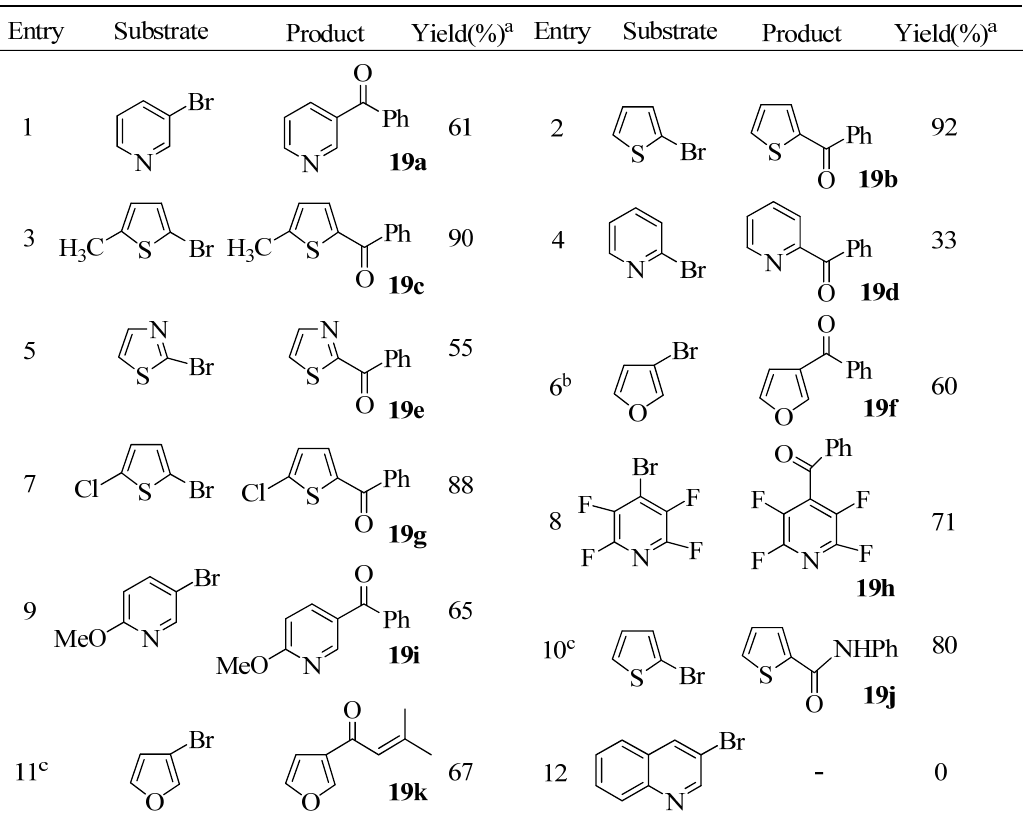
Table 19. Coupling reaction of heteroarylmanganese